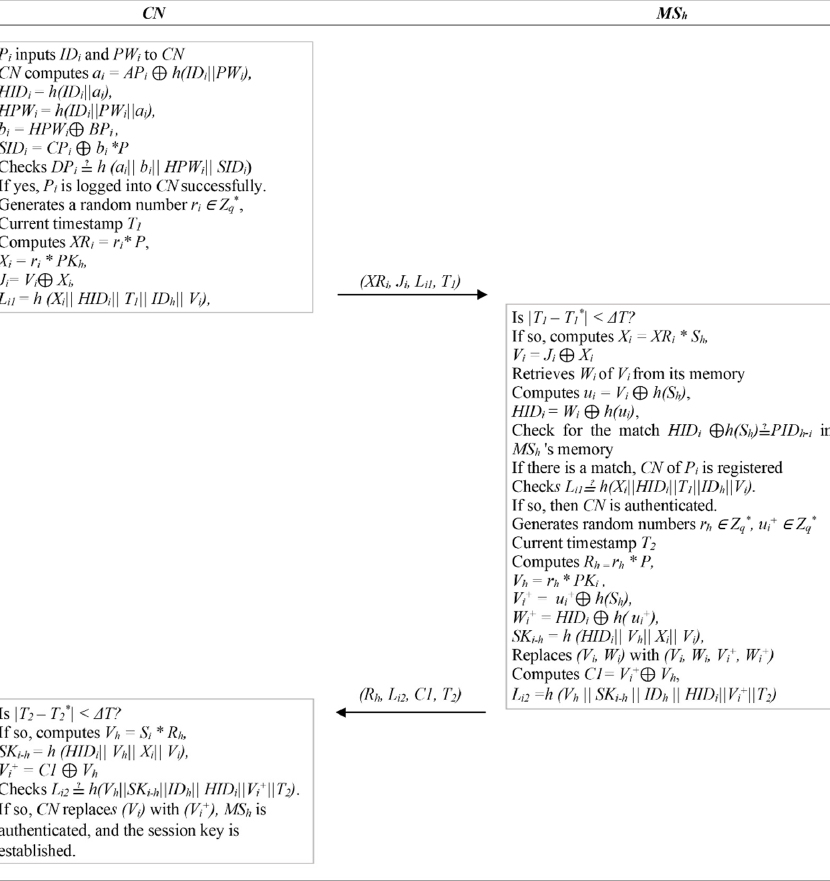
Figure 4. Authentication P-I.